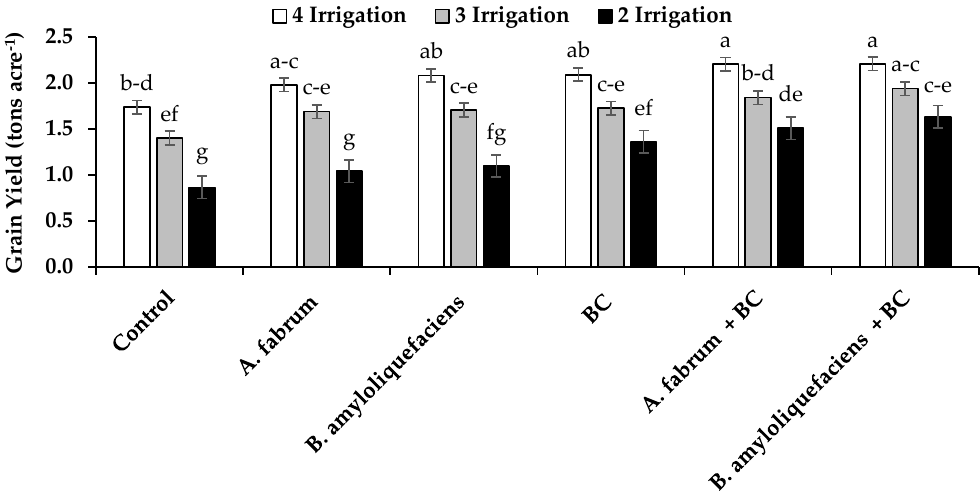
Figure 1. E ff ect of Agrobacterium fabrum , Bacillus amyloliquefaciens with / without biochar (30 Mg ha − 1 ) on Figure 1. Effect of Agrobacterium fabrum , Bacillus amyloliquefaciens with/without biochar (30 grains yield (tons acre − 1 ) in wheat cultivated in drought-stressed field